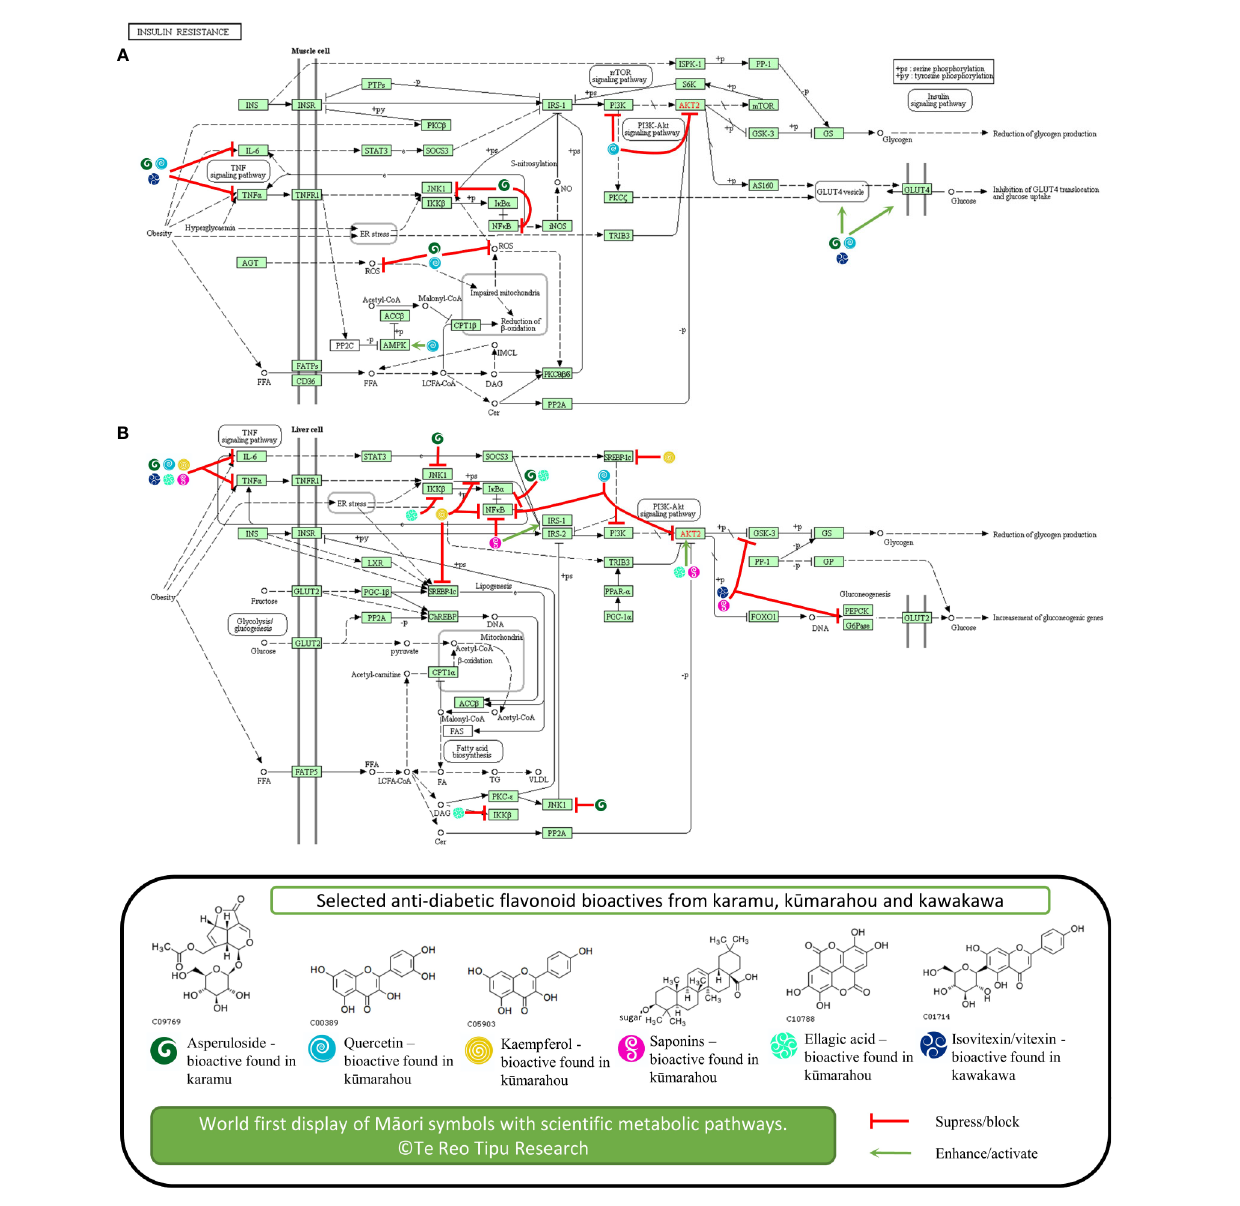
FIGURE 1 | Potential anti-diabetic molecular modes of action of selected fl avonoids known in karamu, ku ̄ marahou, and kawakawa in (A) liver and (B) muscle cell tissue associated with insulin resistance. The fi gure is original. Copyright permission was granted to use KEGG pathway and compounds (Kanehisa and Goto,